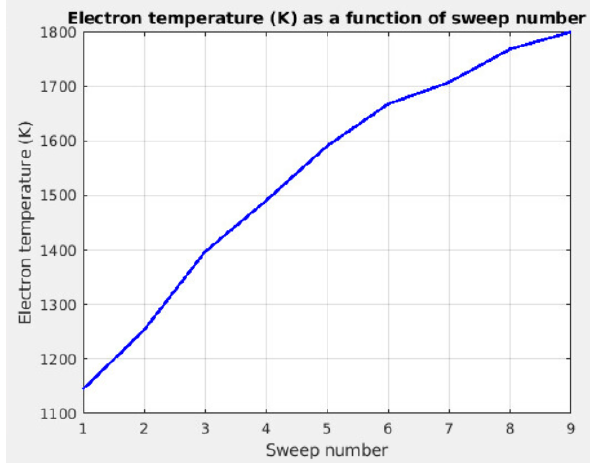
Figure 16. Electron temperature computed without taking into ac- count the probe surface charging as a function of the sweep number for a series of nine consecutive linear sweeps from − 5 to + 13V.